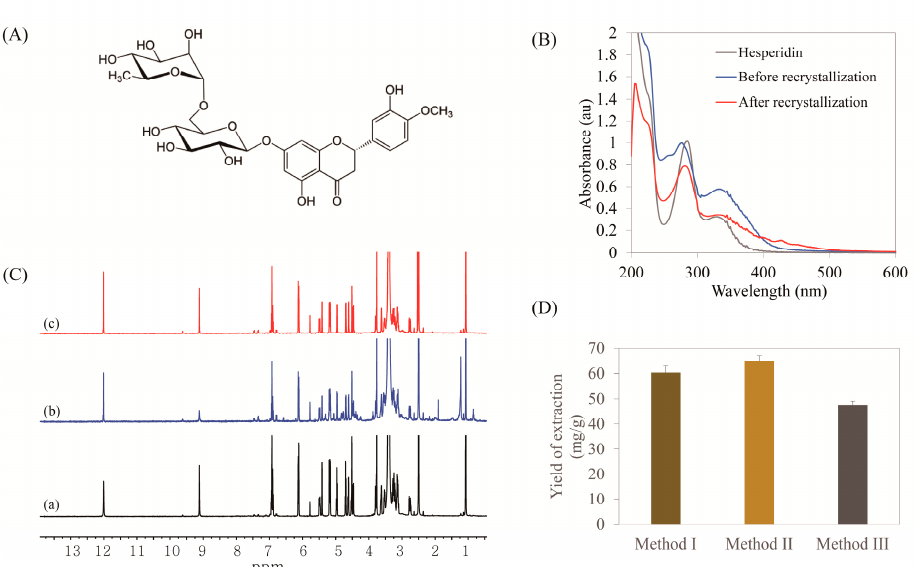
Figure 5. ( A ) Structure of hesperidin. ( B ) UV–vis spectra of commercial hesperidin and hesperidin